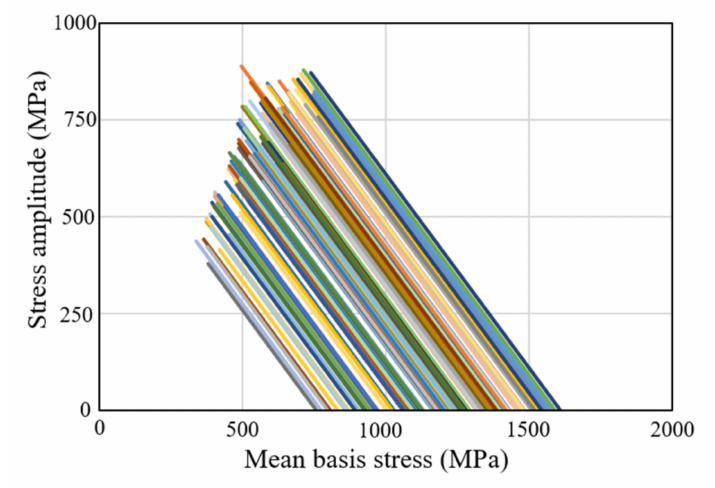
Figure 7. Cyclic stress features of shrink ring U.